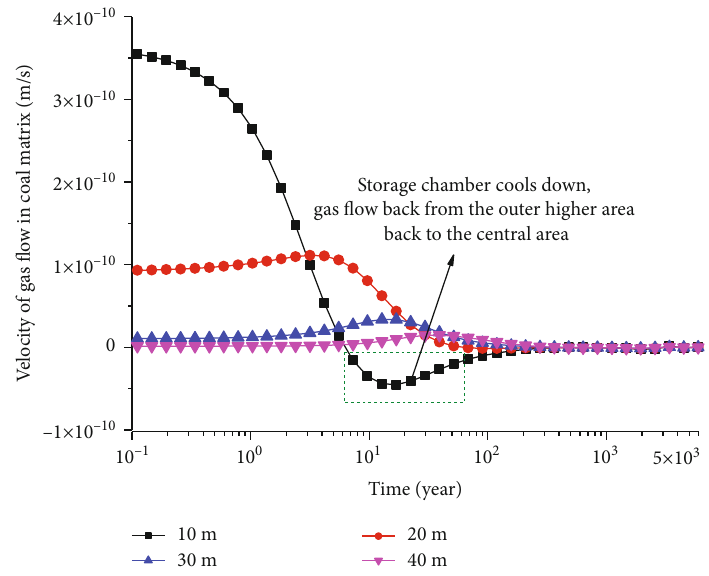
Figure 8: Velocity of gas fl ow in the coal